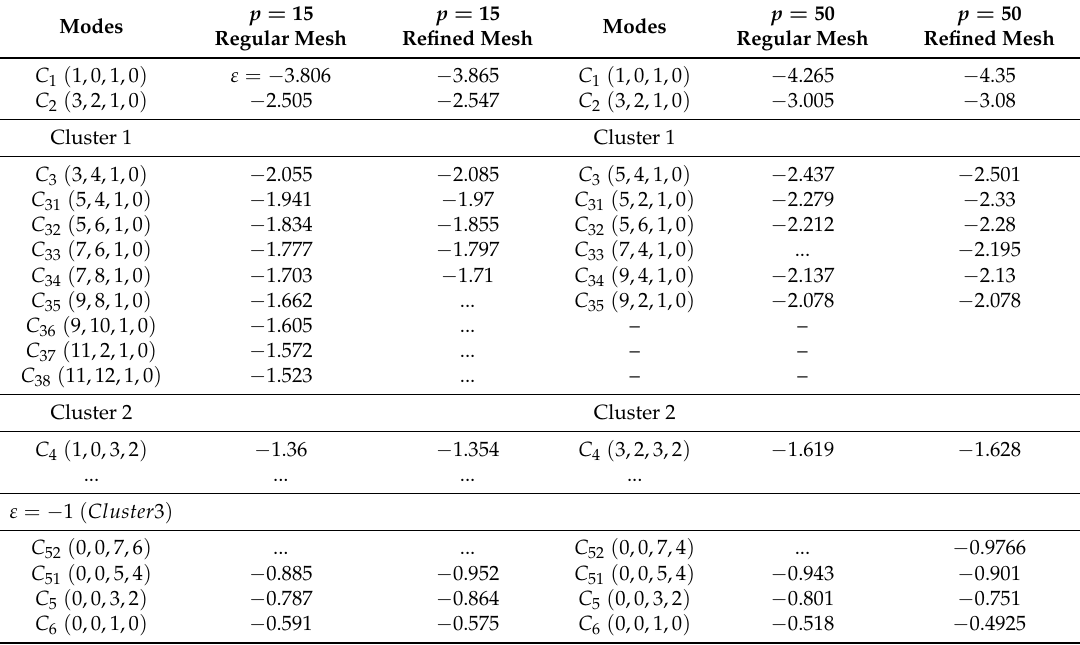
Table A1. Summary table of the position of the electrostatic resonances of a cube for two different p values and two different